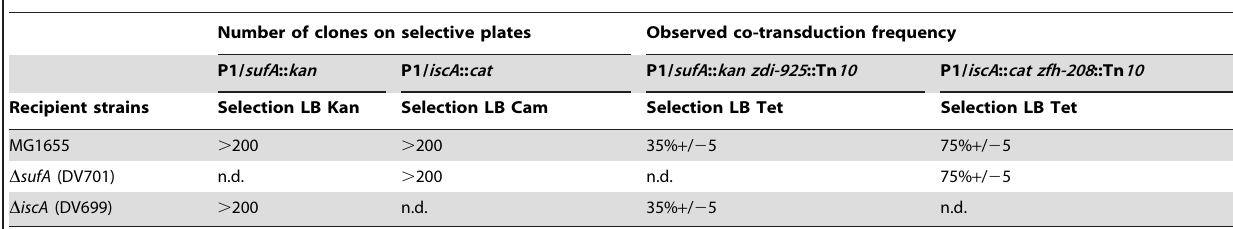
Table 3. iscA and sufA mutations are not synthetically lethal in the absence of oxygen.